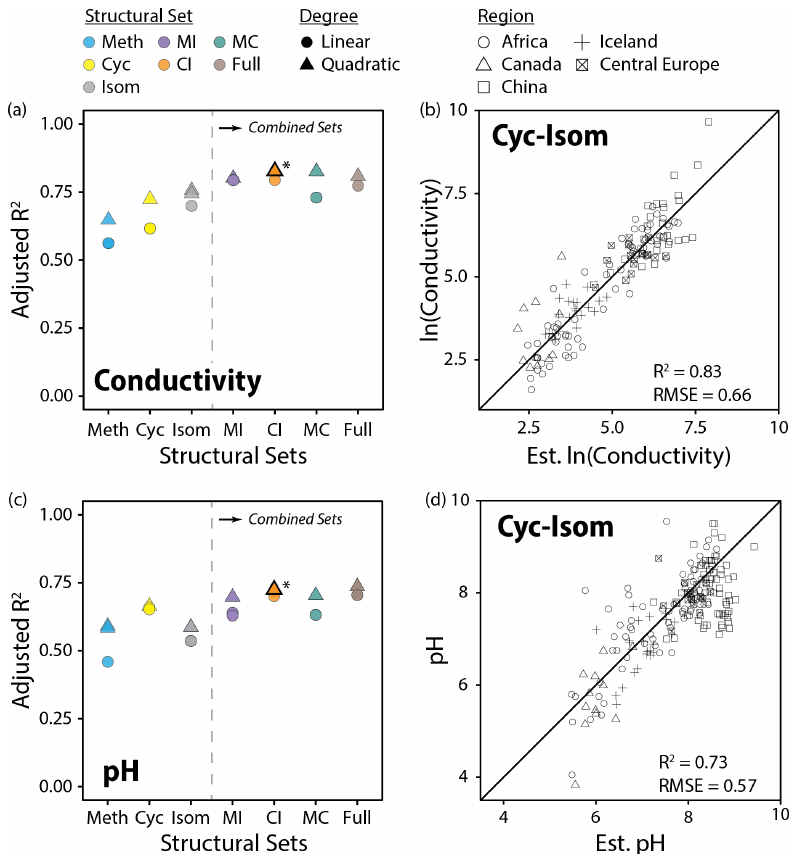
Figure 11. Performance (adjusted R 2 ) of all linear and quadratic fits for lake water conductivity (a) and pH (c) and brGDGT fractional abundances (FAs) calculated within the basic (Meth, Cyc, Isom; left of dashed lines) and combined (Meth–Isom (MI), Cyc–Isom (CI), Meth–Cyc (MC), and Full sets; right of dashed lines) structural sets. Results of both the SFS/SBE and combinatoric fitting methods are plotted. The fits we suggest for general use (CI set, quadratic, combinatoric, for both variables; Eqs. 12 and 13) are bolded and marked with an asterisk in (a) and (c) and plotted in (b) and (d) . “Est. ln(Conductivity)” and “Est. pH” are the natural logarithm of lake water conductivity and pH estimated using these suggested